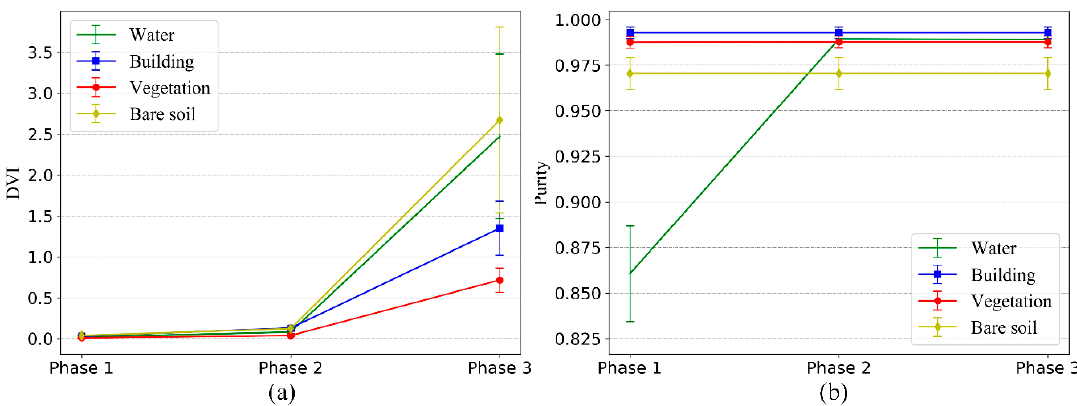
Figure 8. The mean and standard deviation curves of each phase. ( a ) The DVI of each phase. ( b ) The purity of each phase.